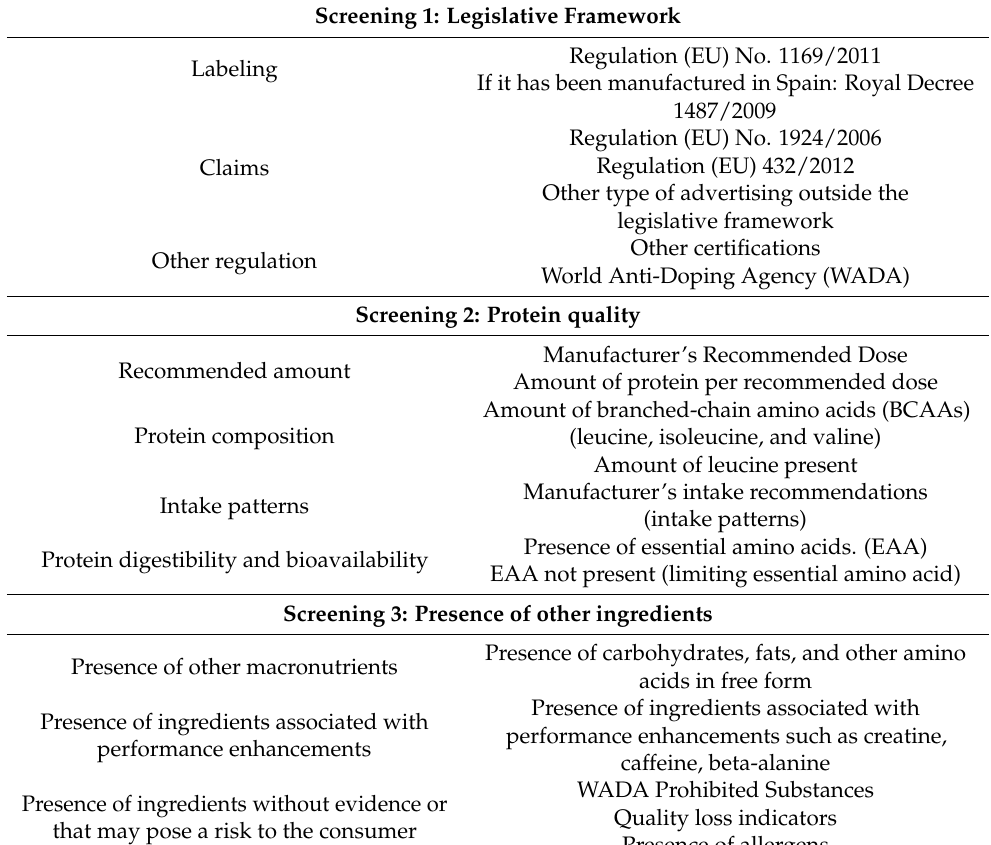
Table 1. Screening components are included in the supplement database. Screening 1: Legislative Framework